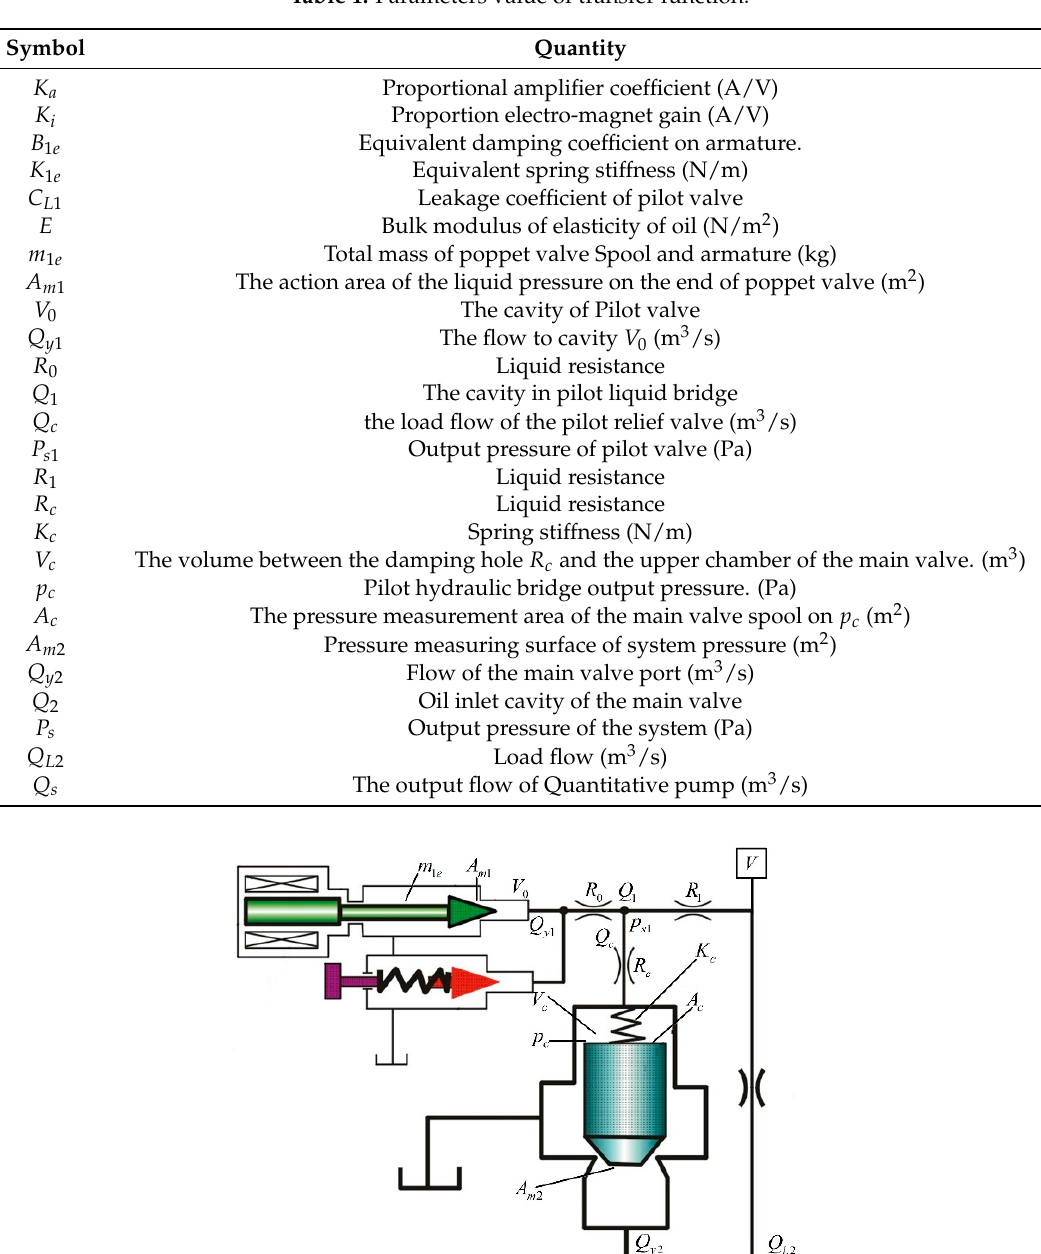
Table 1. Parameters value of transfer function.